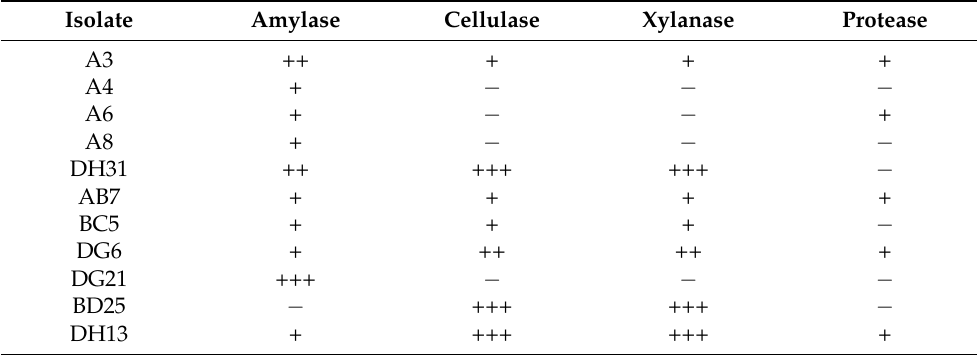
Table 4. Results of hydrolytic assays of bacterial